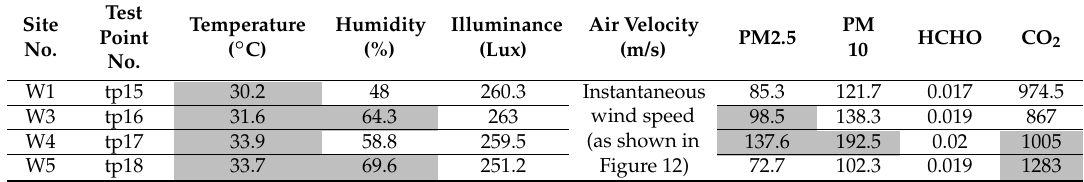
Table 9. Average values for the physical test results from the platform layer.